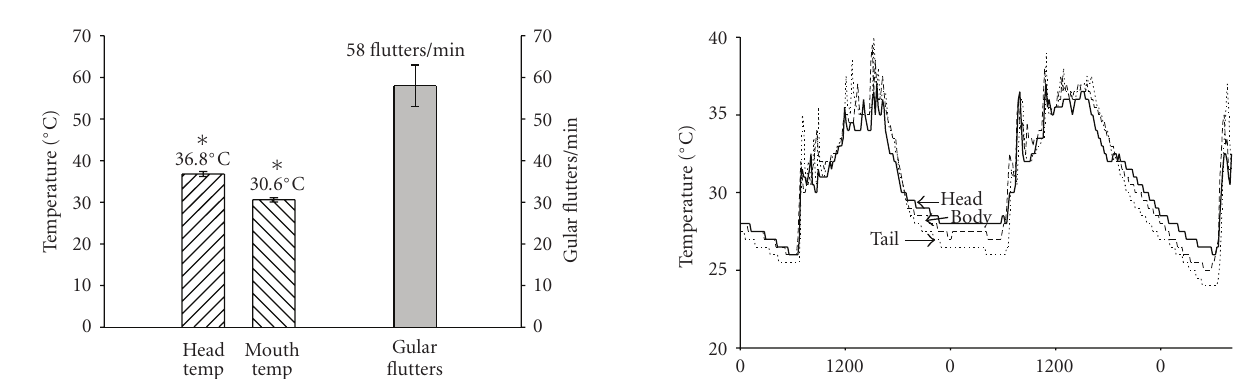
Figure 5: Mean temperature ( ◦ C) of the mouth and head/neck of 5 large Komodo dragons during bouts of gular fluttering. The grey bar depicts the mean number of gular flutters during an individual bout. Vertical line represents SEM. Asterisk depicts a significant di ff erence between means at the P < . 05 level.